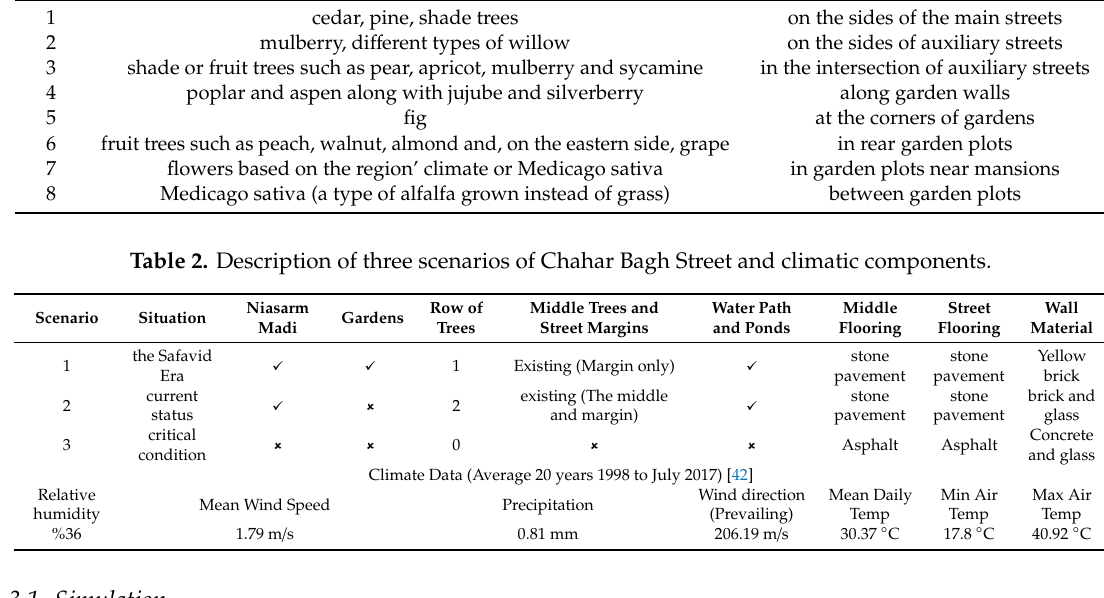
Table 2. Description of three scenarios of Chahar Bagh Street and climatic components.